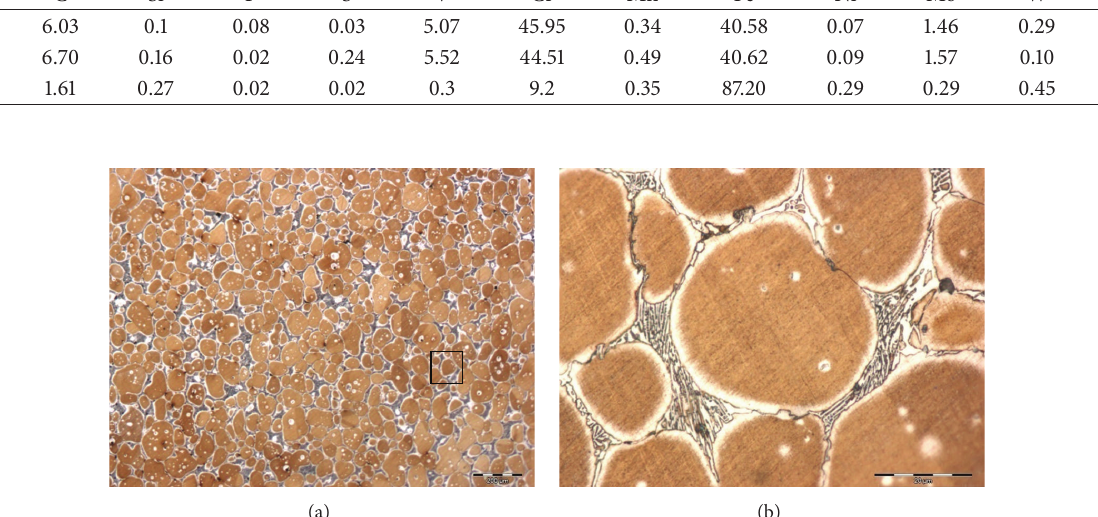
Figure 6: Microstructural development of AISI D2 after DPRM at 1300 ∘ C with a holding time of 5 minutes; (b) is the area within the black rectangle shown in